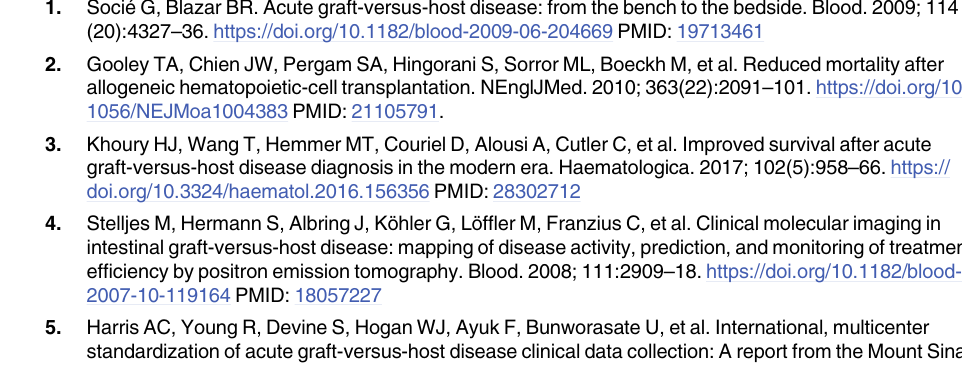
S32 Fig. Univariate COX regression of non-relapse mortality versus steroid application and response in patients with AML disease. Forest plot of regression result depicting case numbers, hazard ratios, confidence intervals and p-values. (TIF) S33 Fig. Univariate COX regression of overall survival versus steroid application and response in patients with AML disease. Forest plot of regression result depicting case num- bers, hazard ratios, confidence intervals and p-values. (TIF) S34 Fig. Univariate COX regression of overall survival and non-relapse mortality versus biopsy count in patients with AML disease. Forest plot of regression result depicting case numbers, hazard ratios, confidence intervals and p-values.